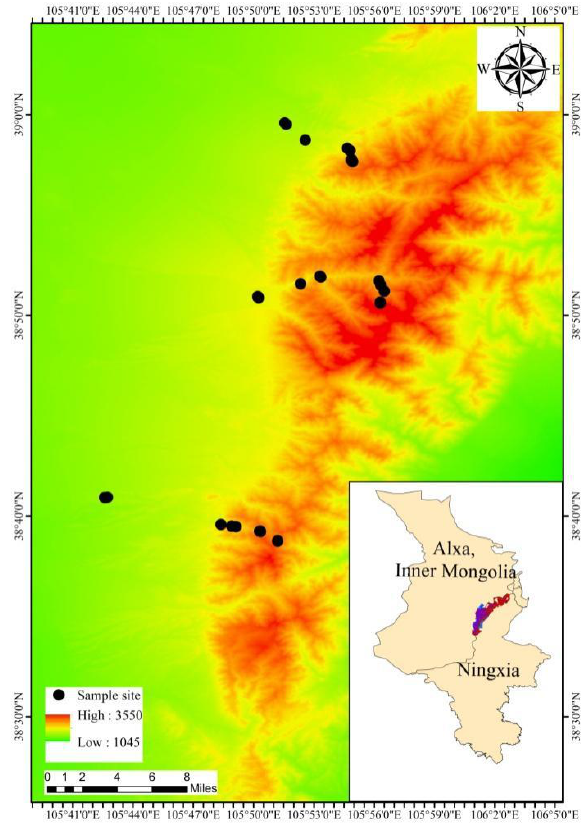
Figure 1. Map of the study area in the Helan Mountains of China, showing the locations of sam- pling sites along the three transects spanning an elevation gradient. sites along the three transects spanning an elevation